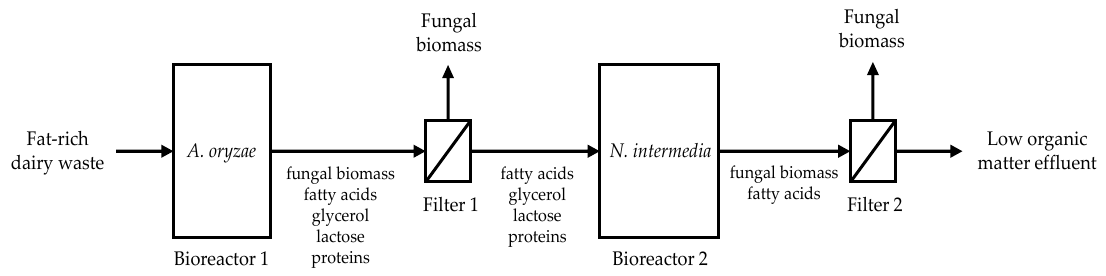
Figure 7. Schematic of the proposed integrated bioconversion process stages for fungal bioconversion of fat-rich dairy substrates to value-added products.